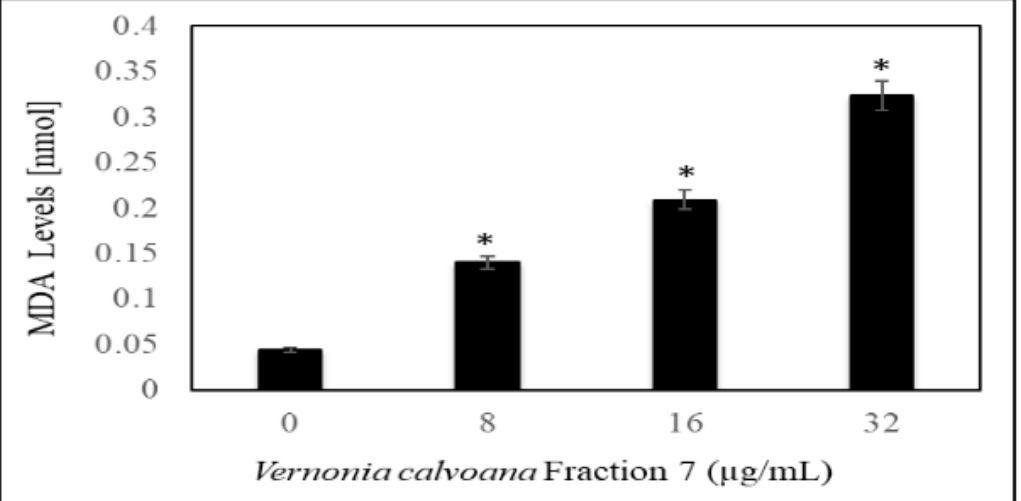
optical resolution of ×